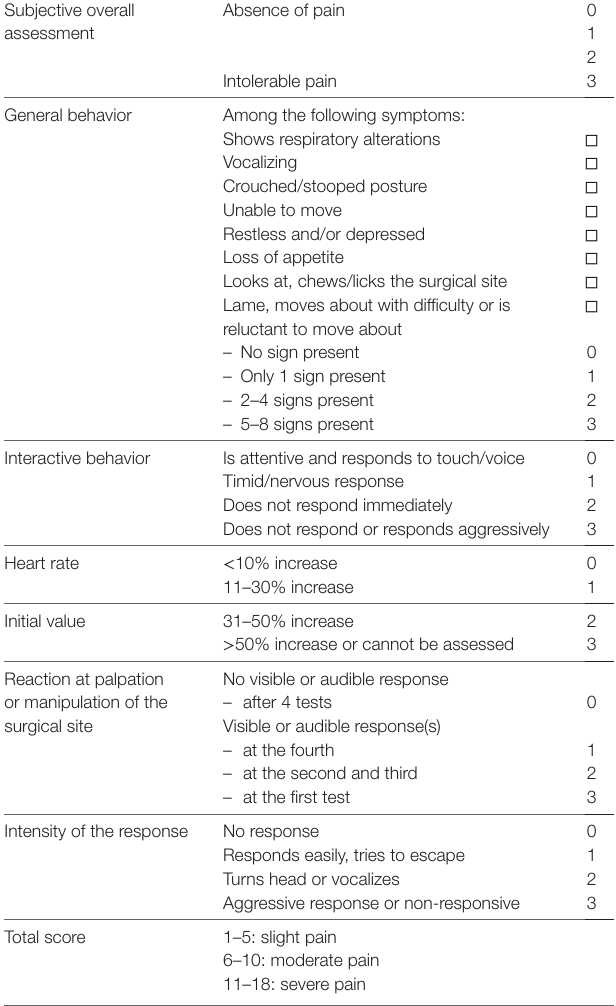
(4A-Vet) multiparametric scoring scale. Subjective overall